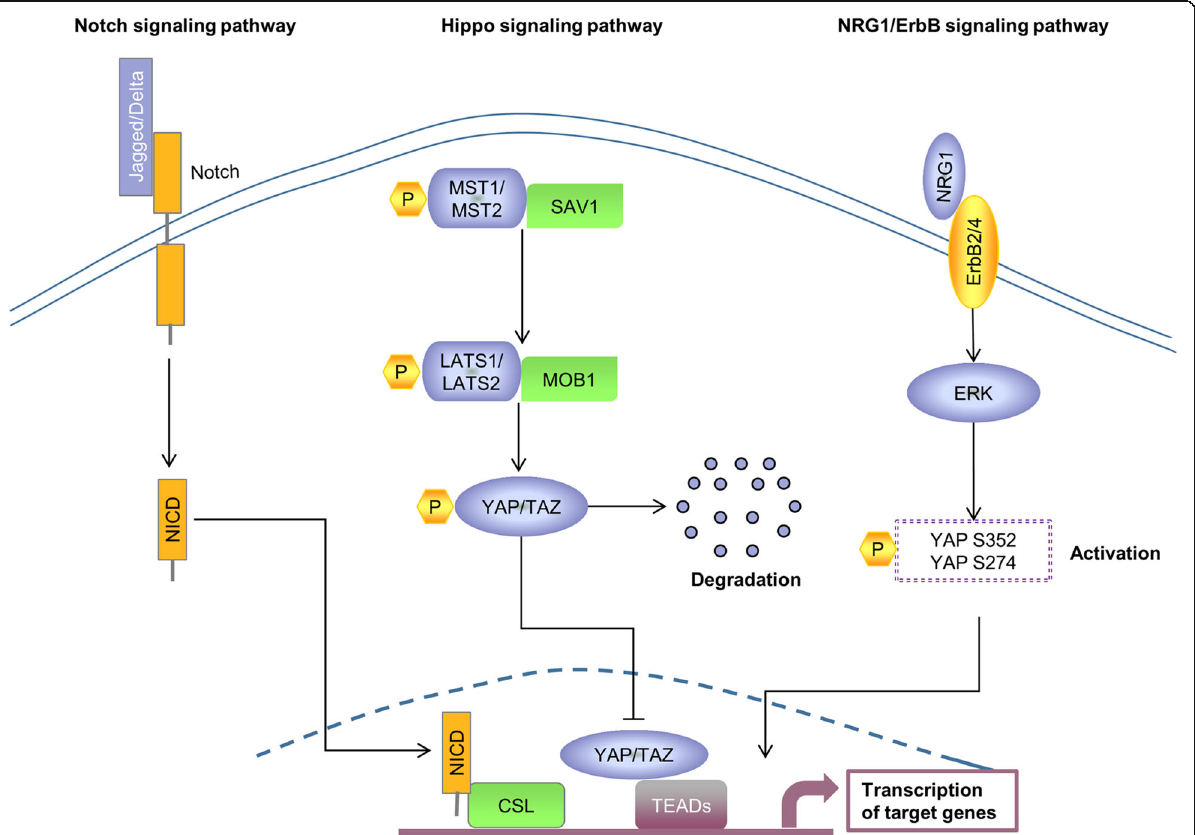
Fig. 2 A sketch of the working model and interactions of the Hippo, Notch, and NRG1/ErbB signaling pathways. Specifically, Notch signaling pathway activation by Jagged/Delta binding to Notch followed by two protein hydrolysis releases NICD into the nucleus, and then NICD binds to CSL for targeting gene expression. However, Hippo signaling is activated by cascade phosphorylation of core kinases (MST1/MST2, SAV1, LATS1/ LATS2, MOB1), which subsequently phosphorylate YAP and TAZ so that they cannot enter the nucleus to bind to TEAD family members. In addition, there is crosstalk between ErbB signaling and Hippo signaling, as ErbB signaling activates ERK and thus phosphorylates the S352 and S274 sites of YAP to promote transcription of target genes; incidentally, this works by acting on the non-classical Hippo/YAP